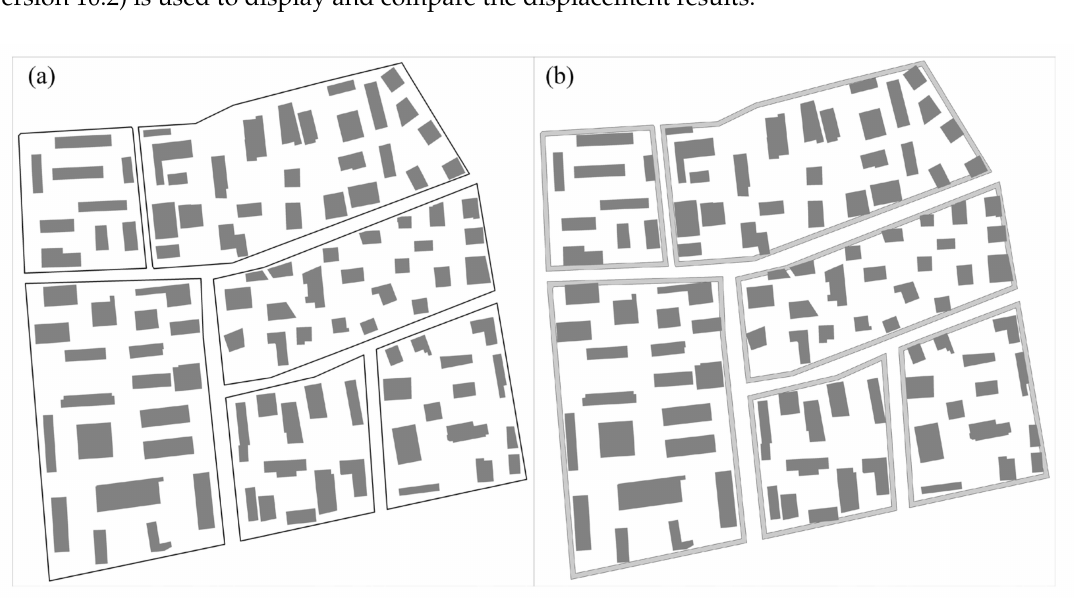
Figure 4. The original experimental data (1:10,000). ( a ) Original data; ( b ) Result of widening the